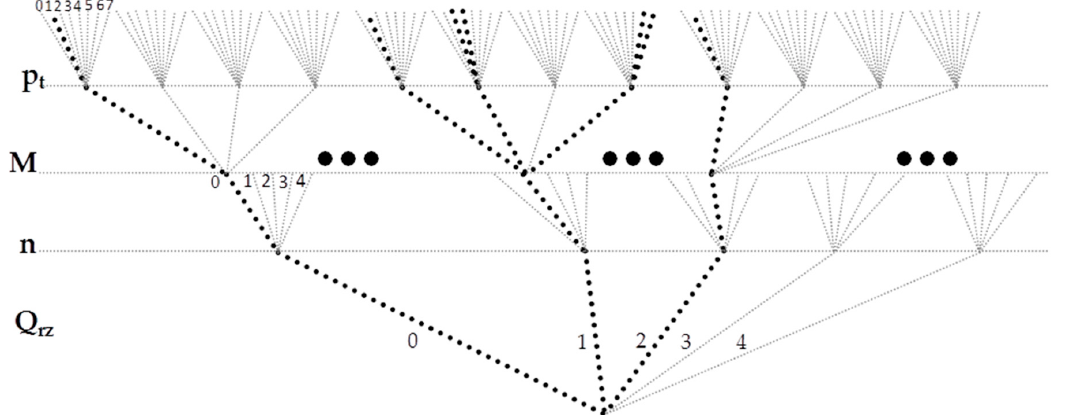
Figure 4. Total efficiency η c .